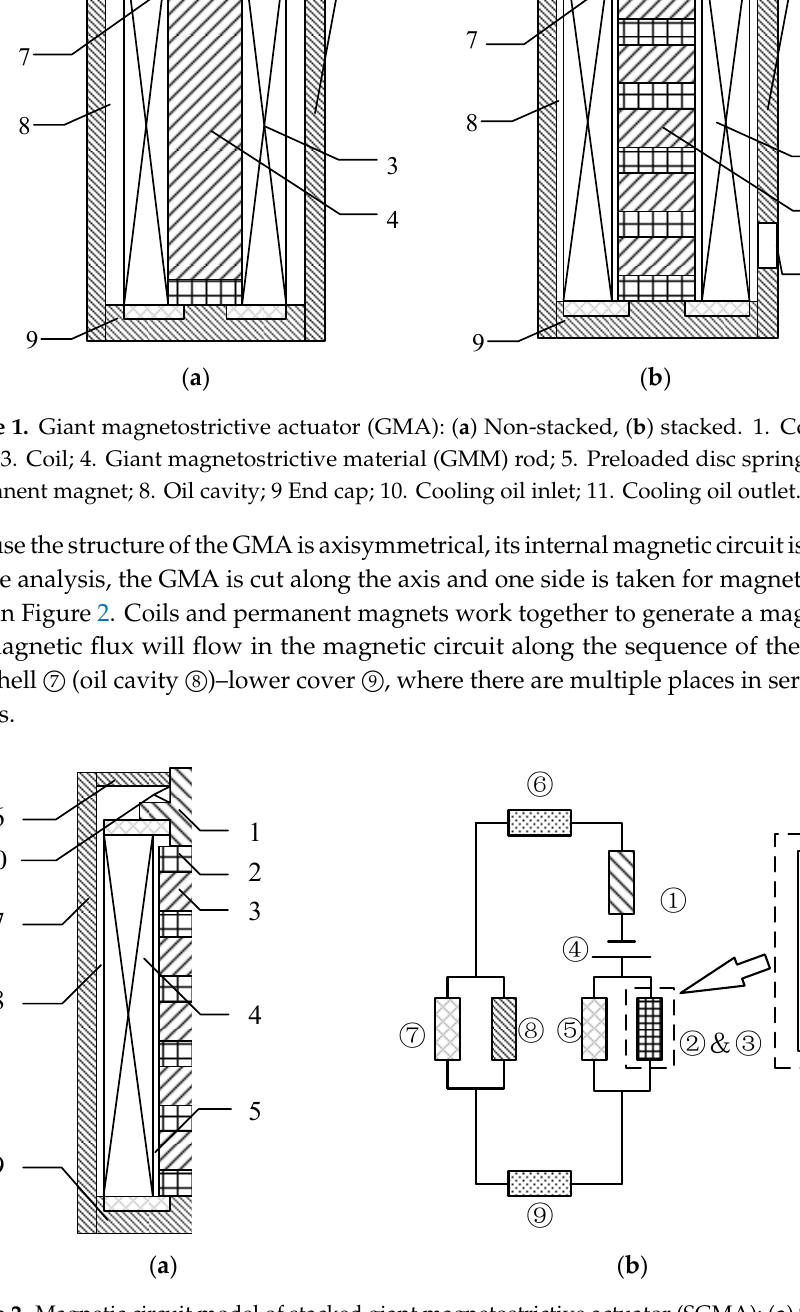
Figure 2. Magnetic circuit model of stacked giant magnetostrictive actuator (SGMA): ( a ) Sectional view of one side of SGMA, ( b ) magnetic circuit model. 1. Ejector; 2. Permanent magnet; 3. GMM rod; 4. Coil; 5. Inner oil cavity; 6. Upper cover; 7. Shell; 8. Outer oil cavity; 9. Lower cover; 10. Preloaded disc spring.